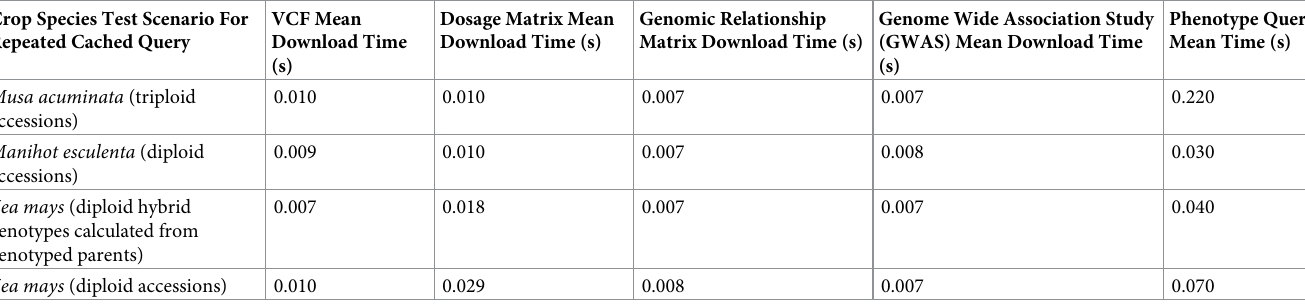
Table 4. Results for repeated query performance from the file